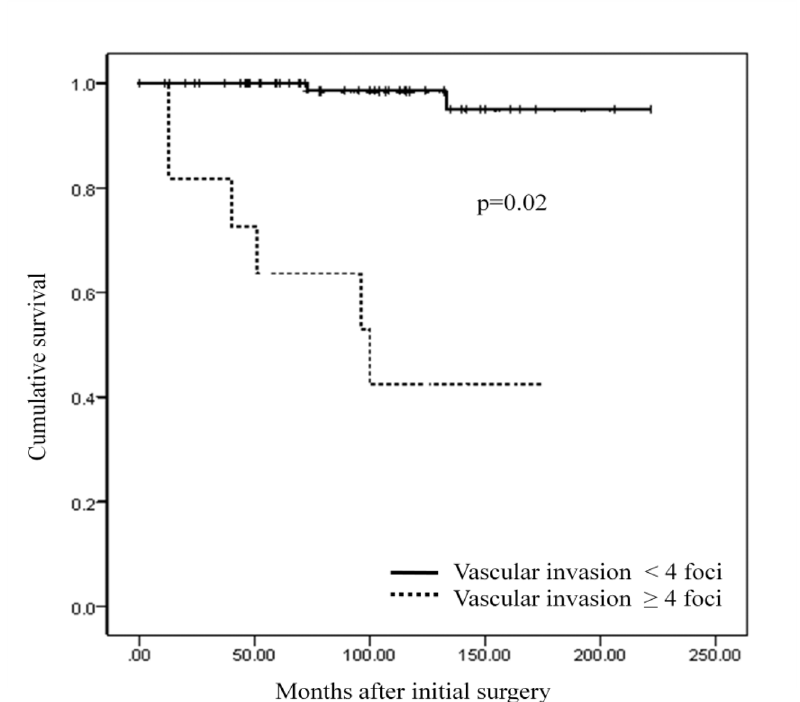
Fig 3. Comparison of recurrence free survival on basis of the presence of extensive vascular